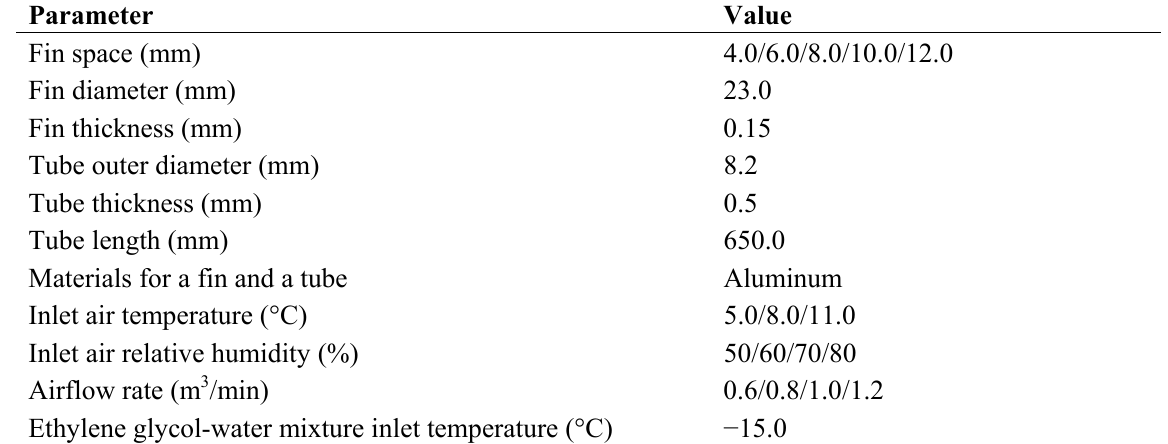
Table 1. Test conditions and